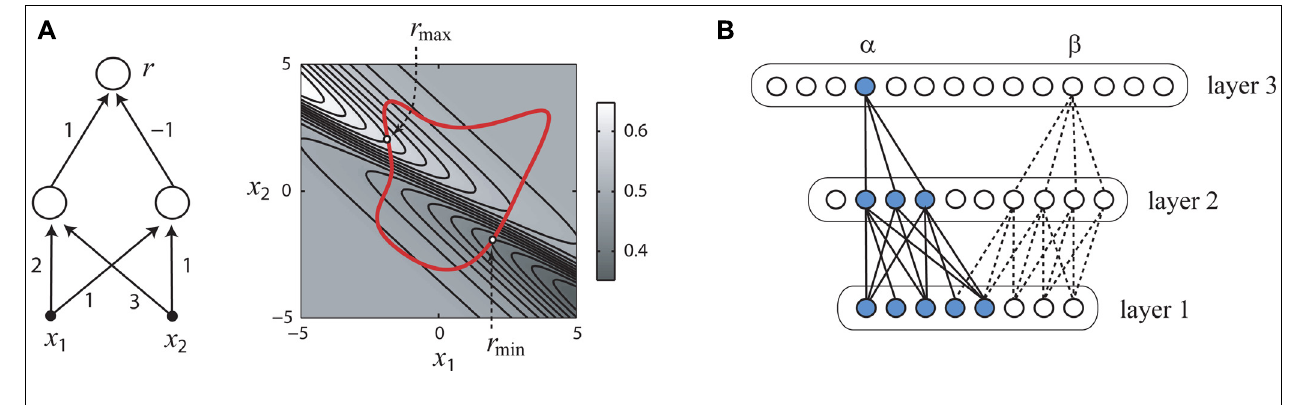
stimuli (right panel, thick red line). (B) The functional network connecting a single neuron ( α or β ) to the sensory periphery may have fewer units in successive processing layers (convergent), even if the overall number of neurons in successive processing layers is increasing